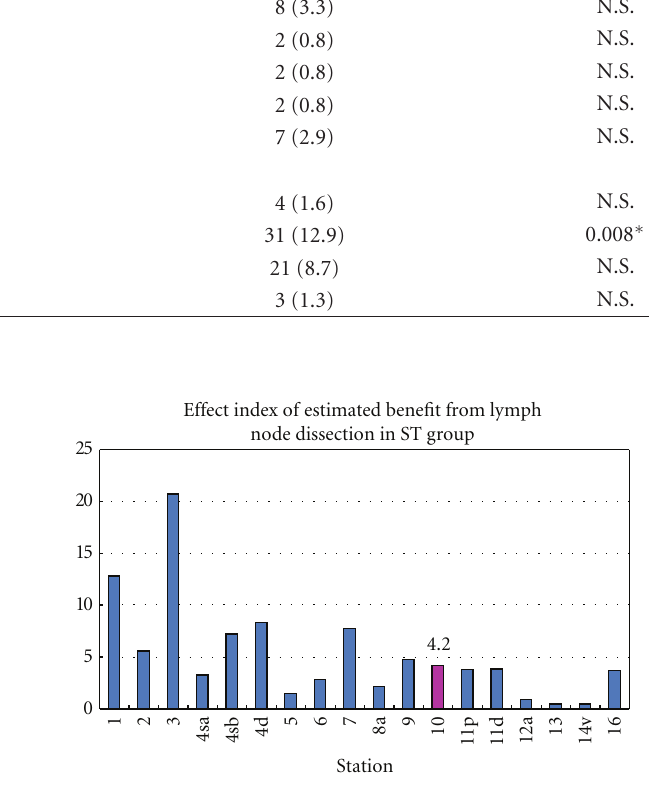
Figure 4: E ff ect index of estimated benefit from lymphadenectomy in ST group. The index was calculated by multiplication of the frequency of metastasis to the station and the 5-year survival rate of patients with metastasis to that station. The index of estimated benefit of No. 10 was approximately equal to that of No. 9, No. 11p, No. 11d, and No.